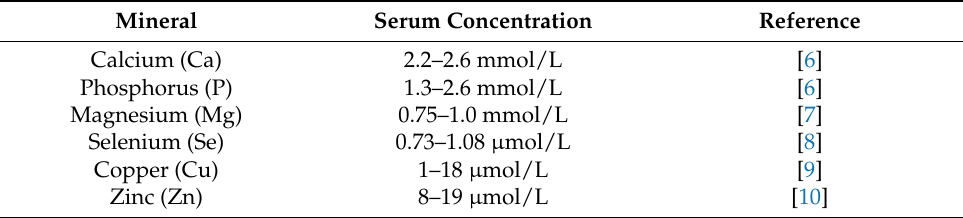
Table 1. Reference values of serum mineral concentrations in dairy cows.